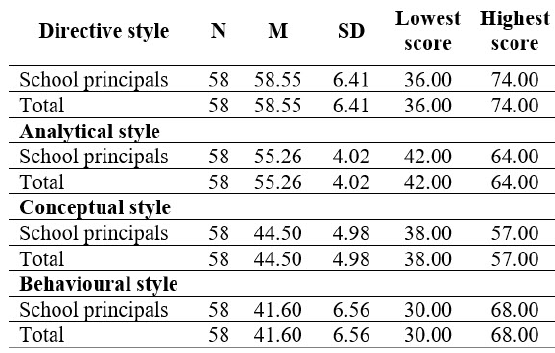
Table 1. Basic statistical indicators for styles of decision making